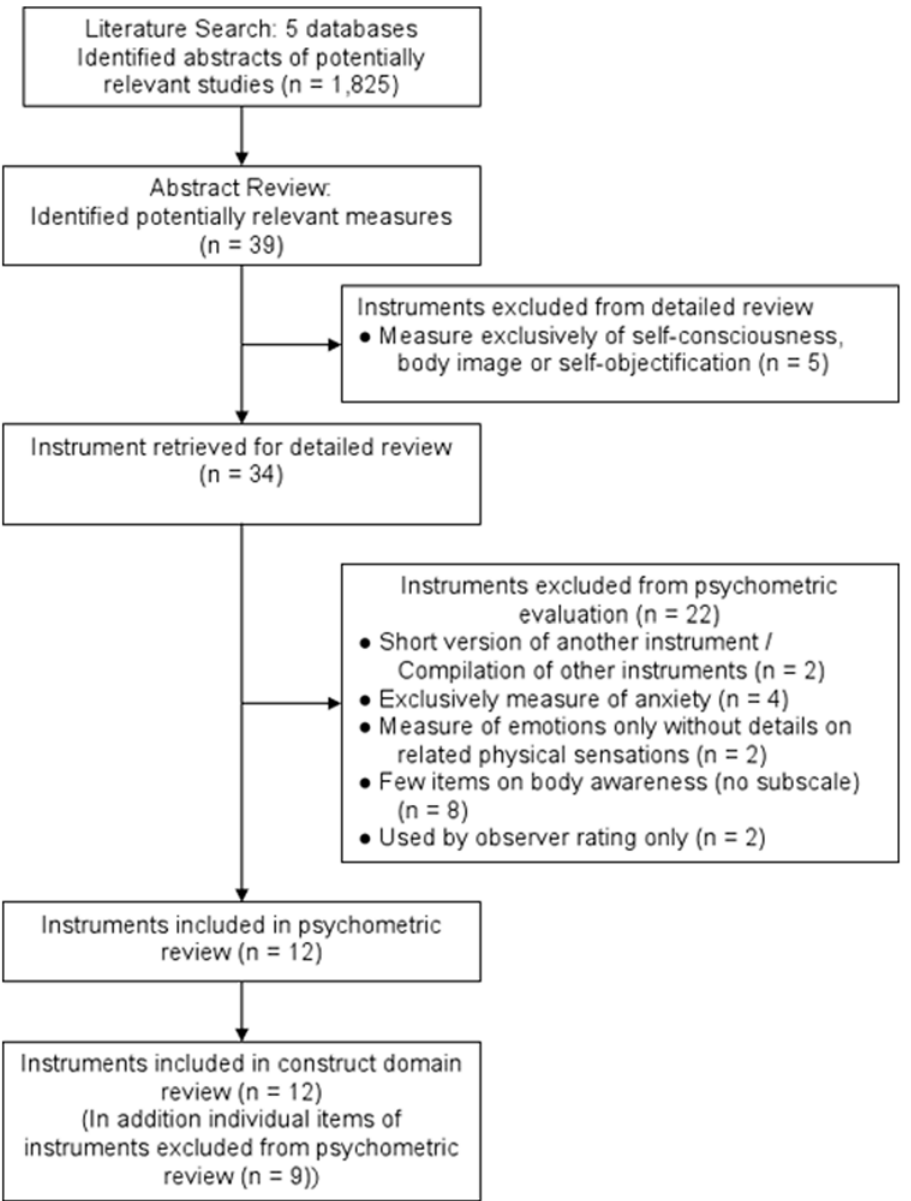
Figure 1. Review Steps.